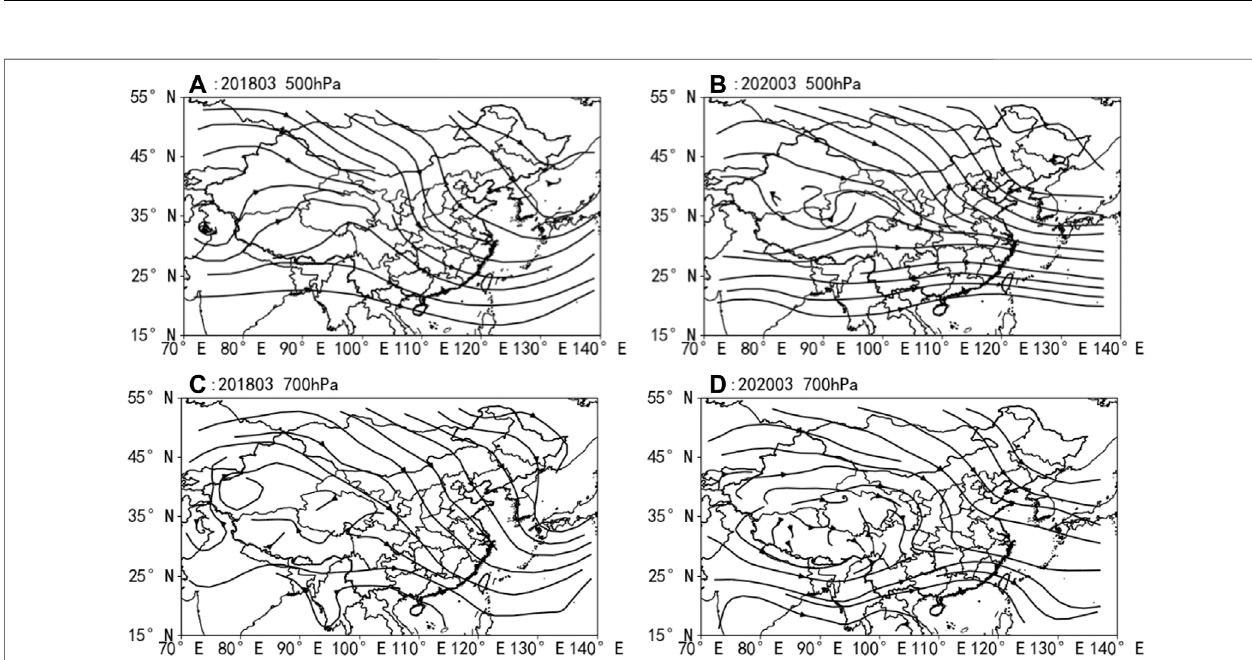
FIGURE2| The fl ow fi eldofthewind(fromwestChinatotheeastSea)at500and700 hPaduringthetwodustprocesses(fromMarch10thtoMarch14thin2018 and from March 18th to March 21st in 2020).